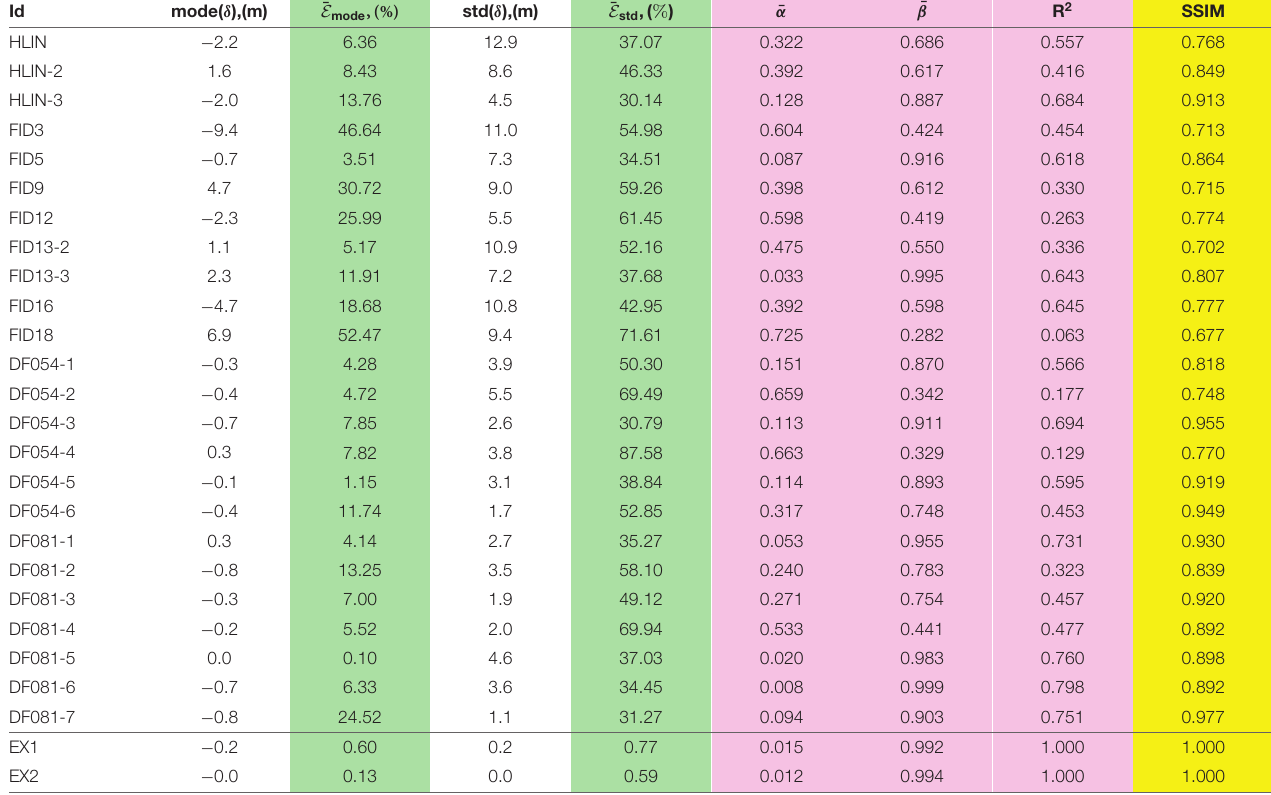
The parameters shaded in light colors indicate normalized non-dimensional assessment indices. EX1 and EX2 are ideal benchmark cases described in Appendix 1